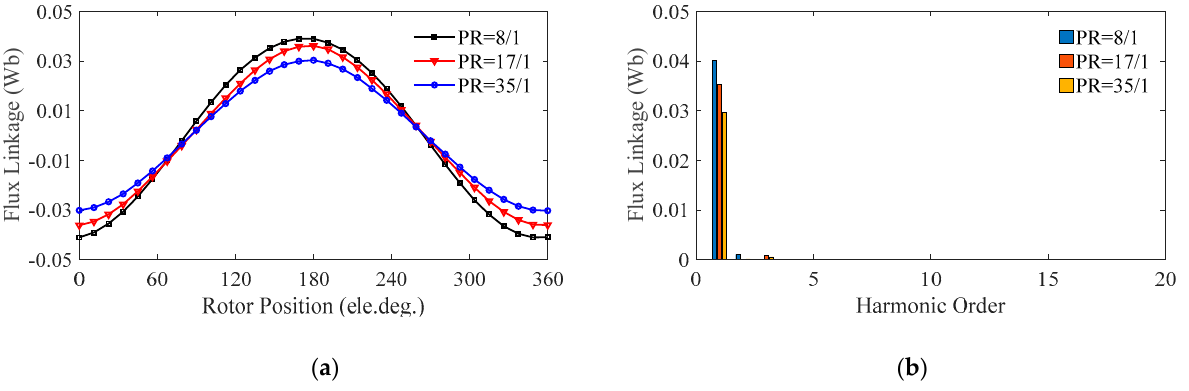
Figure 5. Open–circuit phase flux linkage waveforms and harmonic spectra with different PRs. ( a ) Flux linkage waveforms. ( b ) Harmonic spectra.